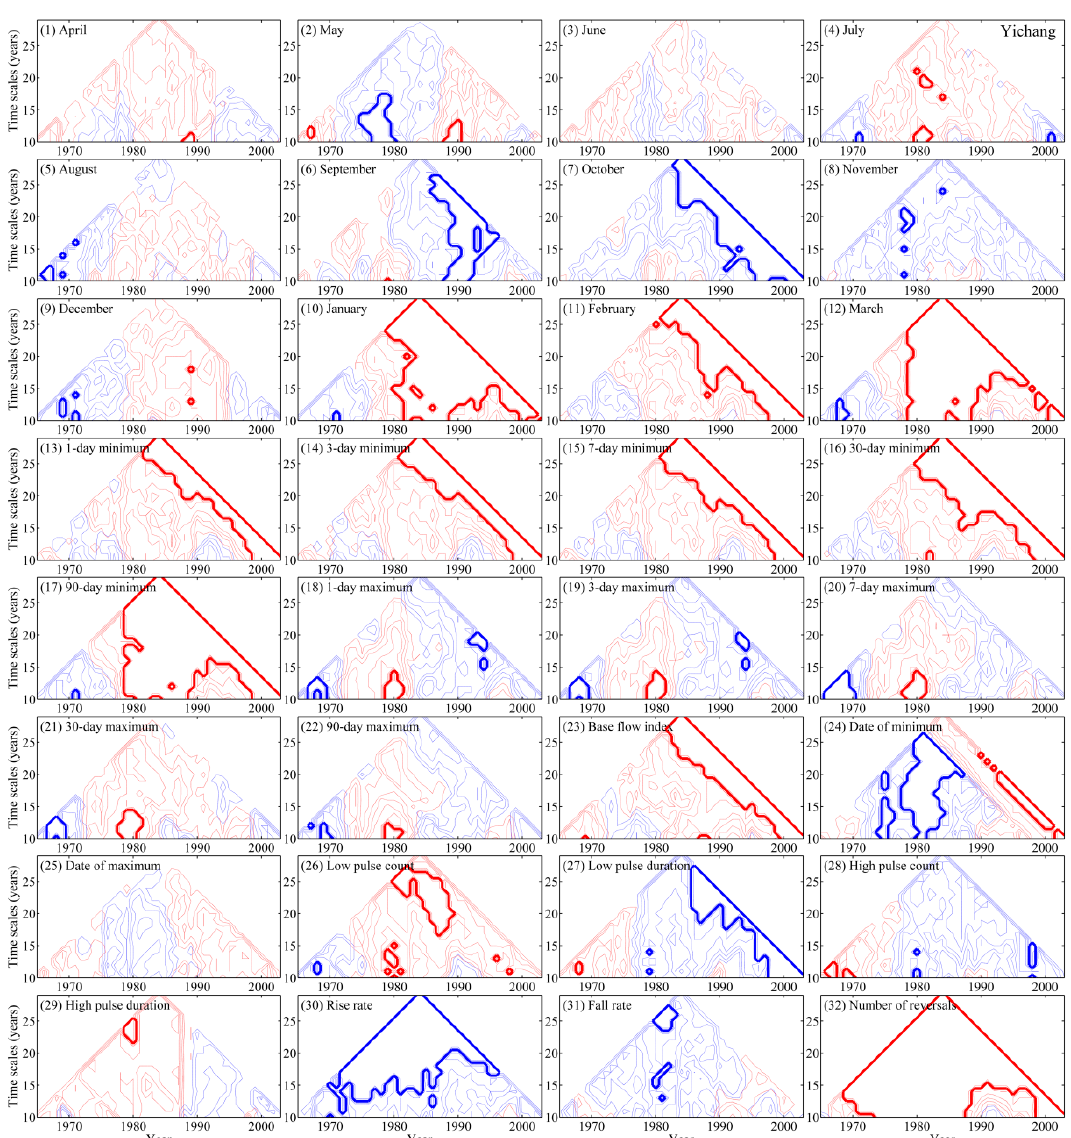
Figure 6. Change points on different time scales of the hydrologic regime at the Yichang station.